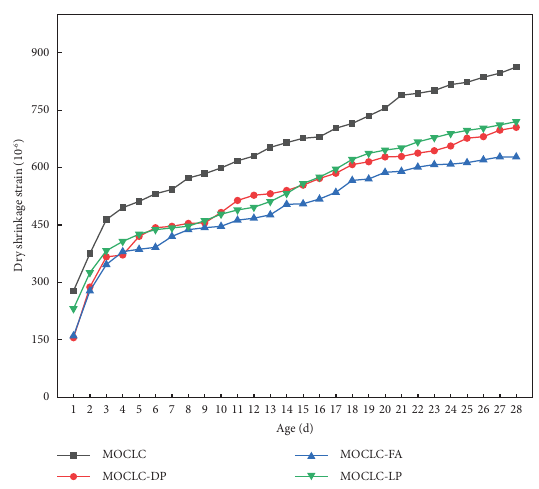
Figure 12: Relationship between dry shrinkage strain and time of diferent